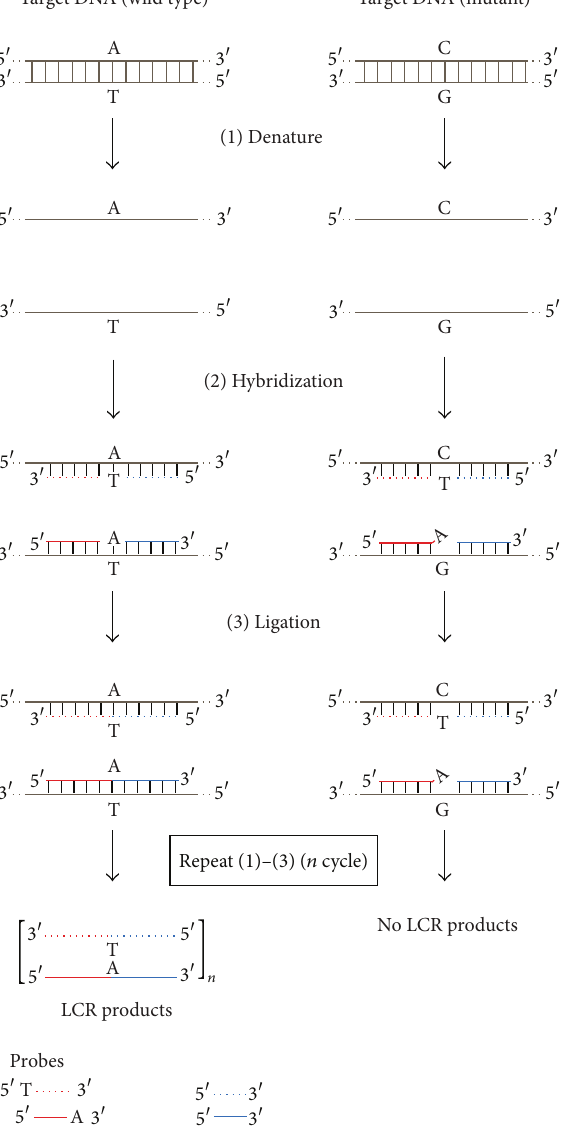
Figure 5: Schematic diagrams for the Ligation Chain Reaction (LCR) and Ligation Amplification Reaction (LAR) processes. (Here, we describe LCR.) DNA fragments from the normal type and the mutant type (at the single nucleotide polymorphism (SNP) site) are shown as reaction templates. (1) The denaturation process is the same as in Figure 3 (1). (2) Hybridization: four oligonucleotide probes, complementary to the normal-type target, hybridize to the target DNA fragment, and (3) Ligation: adjacent probes that are perfectly complementary to the target (left) are connected by DNA ligase. Ligated LCR probes from the first round of the ligation become the targets for the subsequent round using another probe set (dotted lines) complementary to the first set. Thus, the amount of ligated LCR probes increases exponentially. In the case of the mutant type template, the presence of a single-base mismatch at the junction inhibits the ligation, and therefore no ligated LCR probes are formed